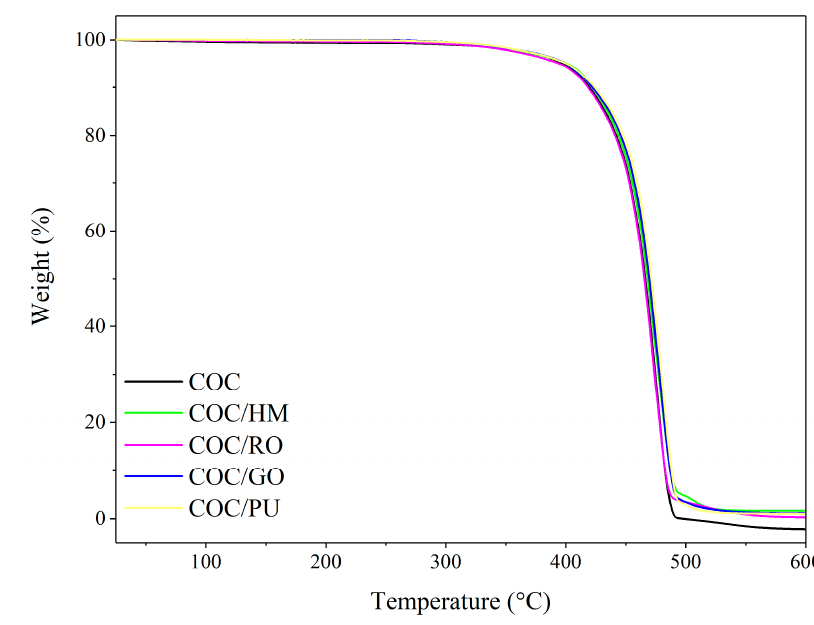
Figure 9. Thermogravimetric (TGA) curves obtained for COC composites filled with different earth pigments measured in an inert atmosphere.